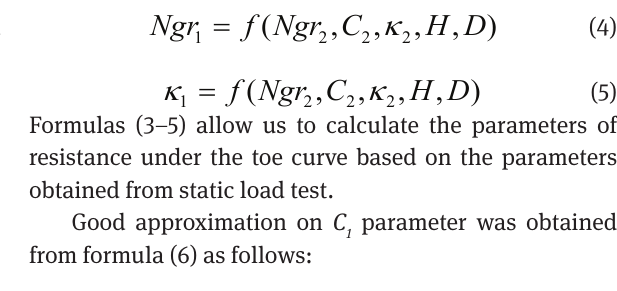
Figure 6: Relationship obtained during the M-K approximation for pile 8.